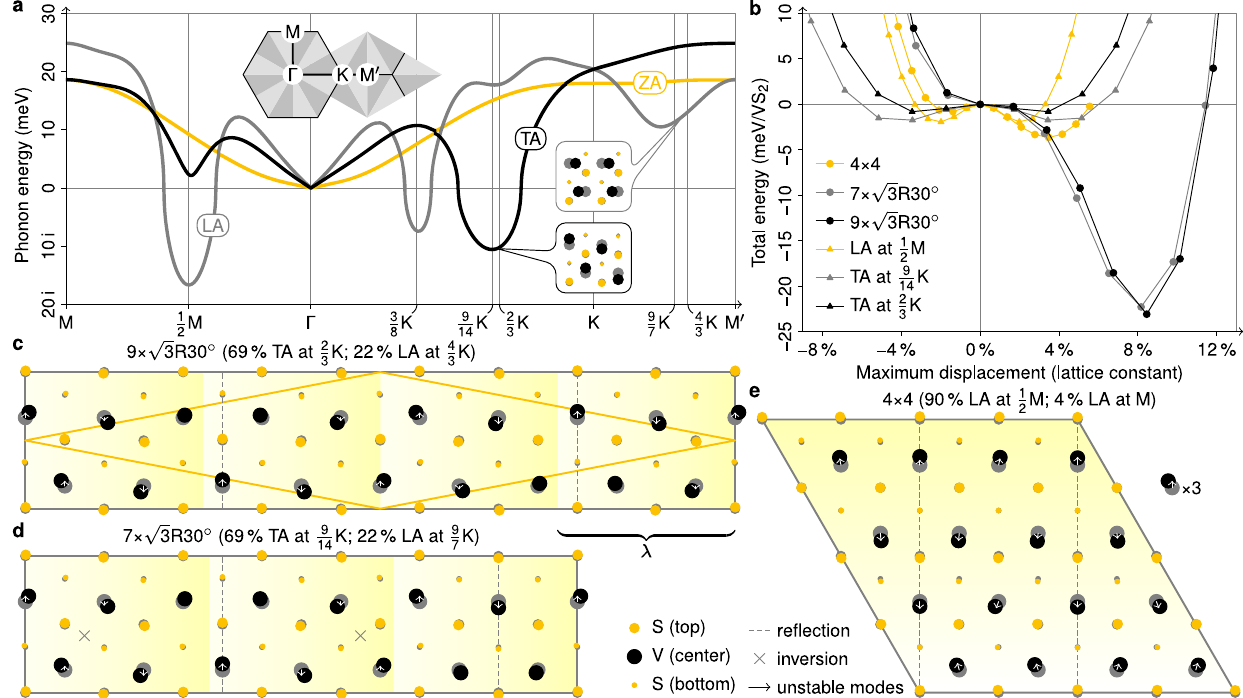
Fig. 2 Lattice instabilities in monolayer 1T-VS 2 from fi rst principles. a Acoustic phonon dispersion from DFPT. LA, TA, and ZA stand for dominant longitudinal, transverse, and out-of-plane atomic displacements. The insets show selected displacement patterns corresponding to indicated modes. b Total energy from DFT as a function of the displacement amplitude for atomic displacements toward relaxed crystal structures and their projections onto ffiffiffi p ffiffiffi p soft phonon modes. c – e Relaxed crystal structures on 9 ´ 3 R30 (cid:4) , 7 ´ 3 R30 (cid:4) , and 4 × 4 unit cells from DFT. Vanadium and sulfur atoms are represented by black and yellow dots, their undistorted positions by gray shadows. Arrows represent the projections of the atomic displacements onto soft phonon modes. (Only arrows longer than 2% of the lattice constant are shown.) The contributions of different phonon modes are quanti fi ed in the fi gure titles. The displacements in c , d are drawn to scale, those in e have been magni fi ed by a factor of three for better visibility. The primitive cell of the structure in c , which is in agreement with the results of ref. 21 , is outlined in yellow. Dashed lines and crosses mark re fl ection planes and inversion centers.